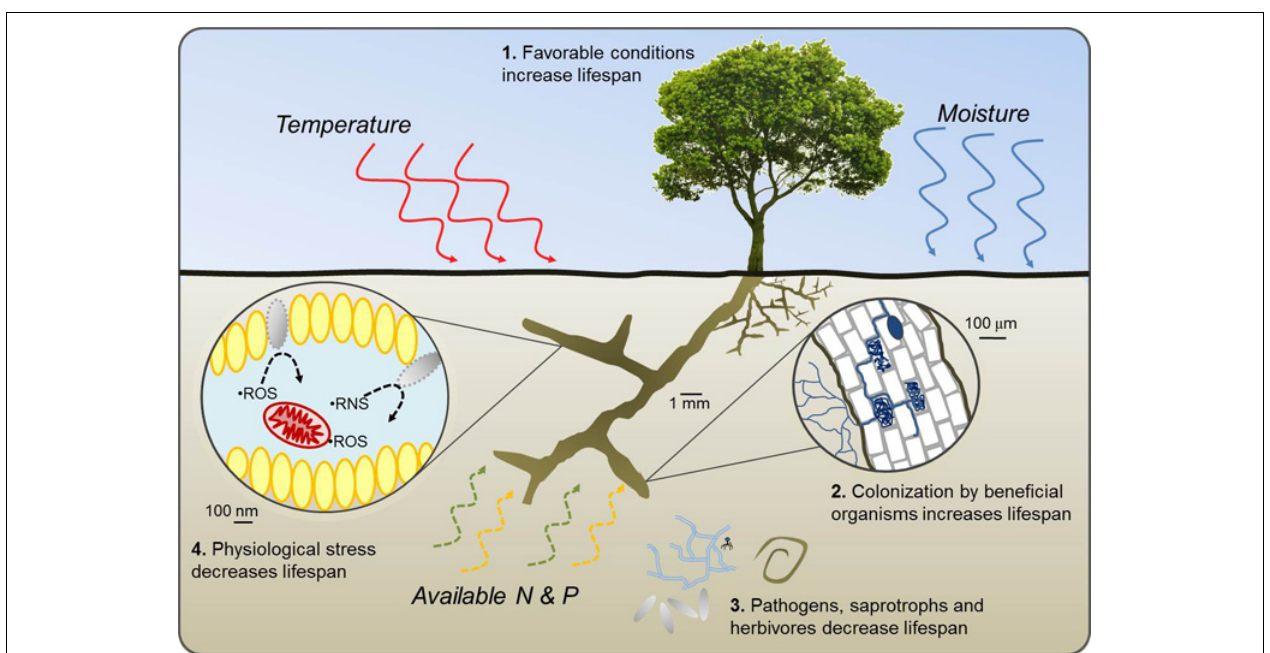
benefiting plant growth by providing nutrients and water resources. Increased pressure from pathogen attack, saprophytic fungi, and herbivores decrease lifespan in Pathway 3 while increased root respiration, excessive production of reactive oxygen species (ROS) and reactive nitrogen species (RNS) and eventual tissue damage under stressful growing conditions decrease lifespan in Pathway 4 . Pathways 1 and 4 can be considered intrinsic responses by the plant or root while Pathways 2 and 3 are driven more by changes in beneficial or antagonistic factors that are extrinsic to the